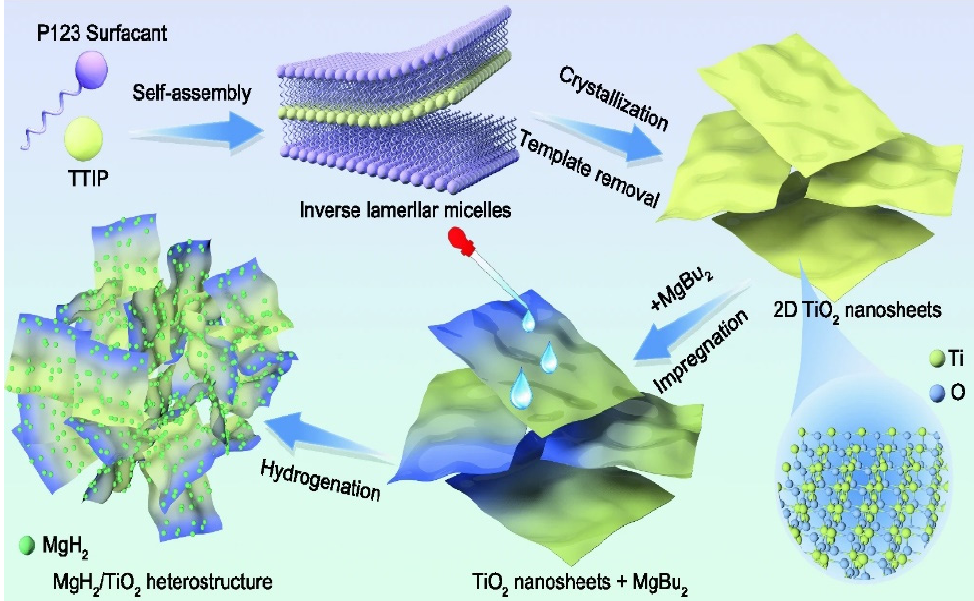
Figure 10. Synthesis process illustration of the MgH 2 /TiO 2 heterostructure. Copyright 2022, Springer Singapore. Reproduced with permission from [114].